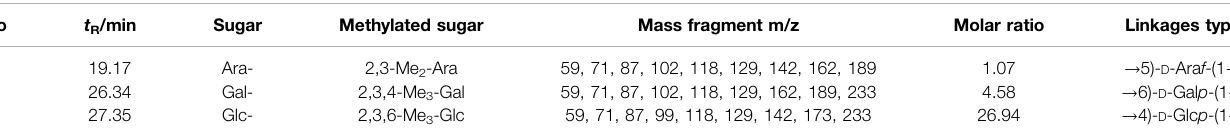
TABLE 4 | Analysis of APS- Ⅲ methylation